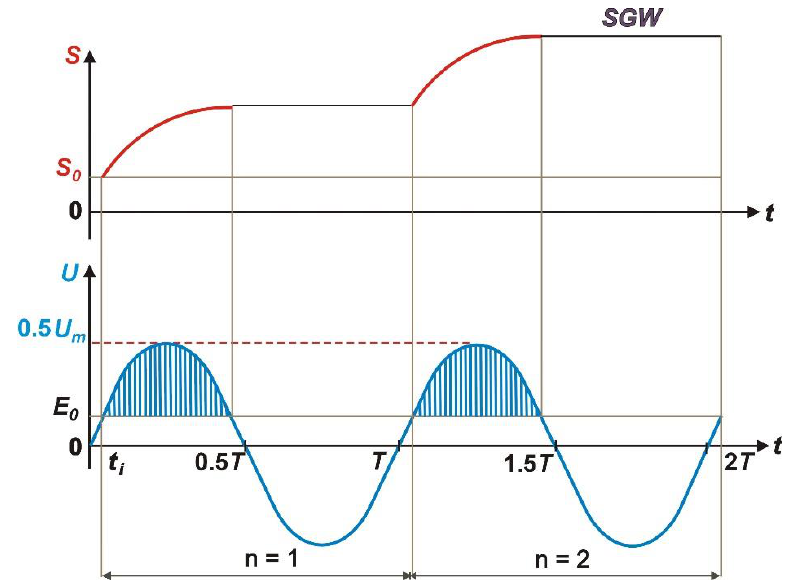
Figure 4. A curve of the inter-electrode voltage U m and inter inter-electrode gap during ECDGW-AC process, SGW — surface of grinding wheel, t i — the time of start of digestion process.